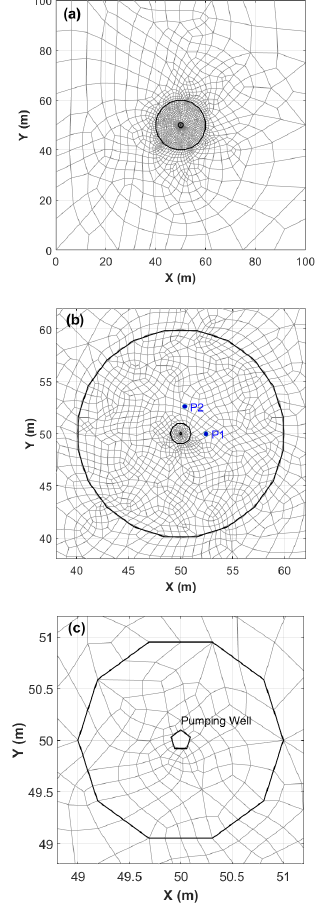
Figure 2. ( a ) Plan view of the unstructured mesh used for simulating the hydraulic head drawdown in an anisotropic aquifer. ( b ) Enlarged view around the first level of mesh refinement within a 10 m radius from the domain center. The two piezometers are shown. ( c ) Enlarged view around the second level of mesh refinement within a 1 m radius from the domain center. The well is approximated with a regular pentagon and has a radius of 0.1 m.